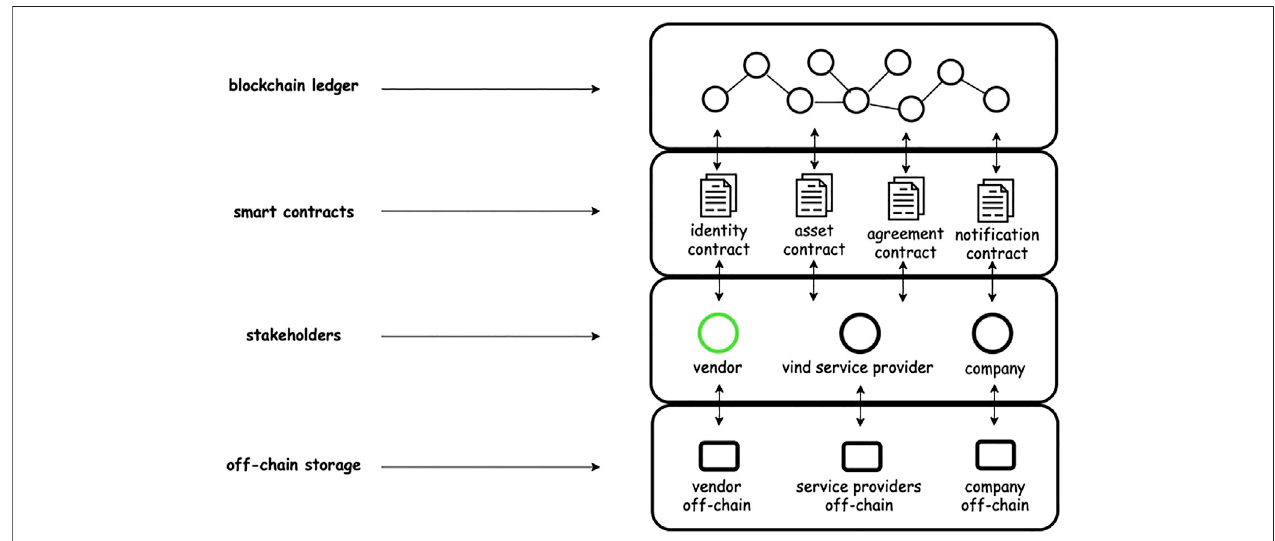
FIGURE 1 | Overview of the Vind architecture. Smart contract de fi nes the application functions in the Vind platform. Blockchain clients (stakeholders) interact with smart contract functions.